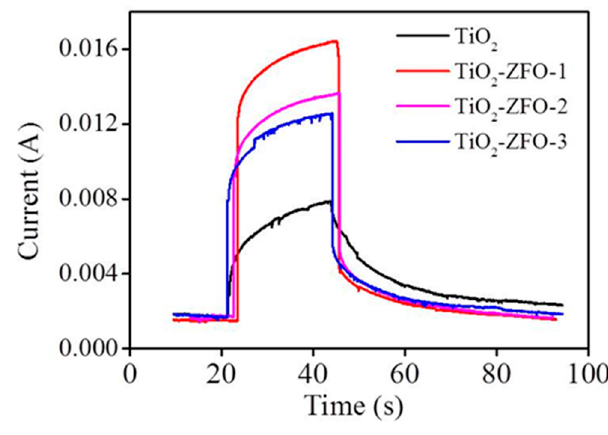
Figure 8. Photocurrent vs. time cures of various nanorods.